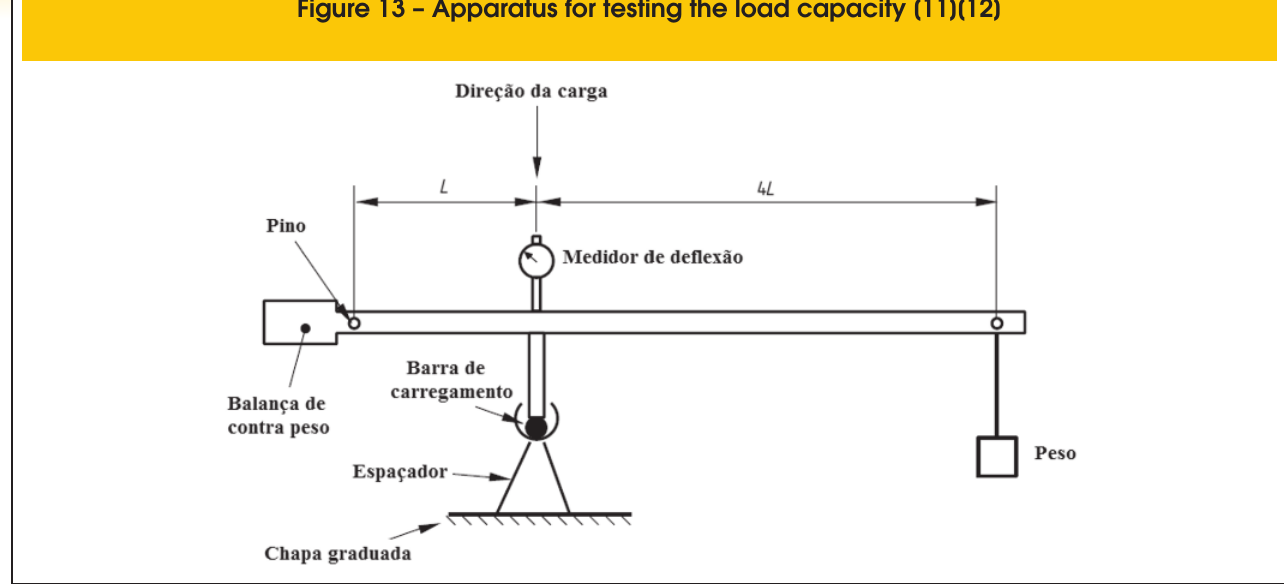
Figure 13 – Apparatus for testing the load capacity [11][12]